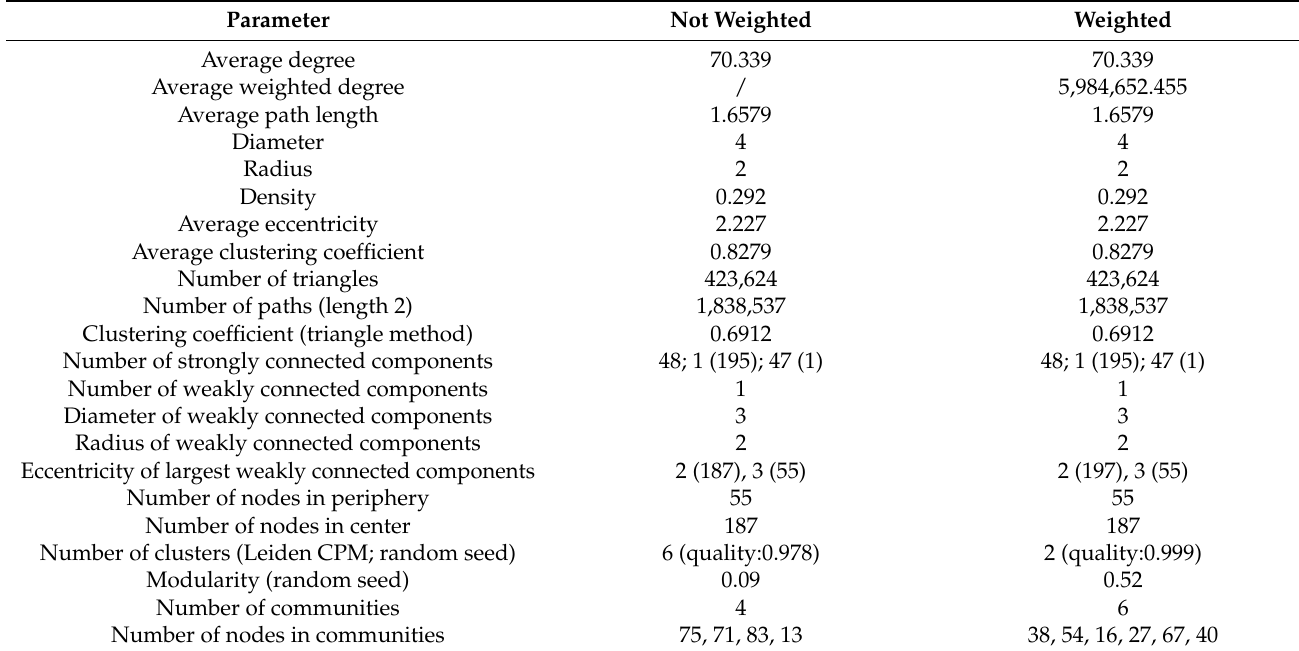
Table 1. Tourism network